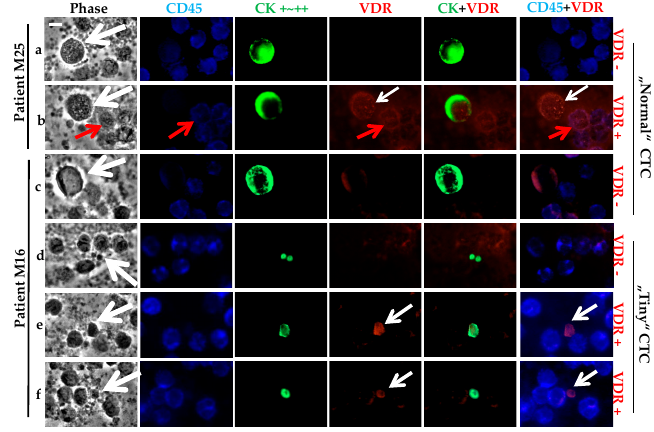
Figure 4. VDR status determination on CTCs of metastatic BC patients. Triple fluorescence labeling of CD45 (in blue), CK (in green), and VDR (in red) was performed on 10 6 PBMCs, with parallel phase analysis. CTCs ( with white arrows ) were classified as VDR+ or VDR-. For both patients M25 ( a , b ) or M16 ( c – f ), either status was observed with superimposed VDR and CK labeling. CTCs exhibit size heterogeneity for patient M16 (“Normal” or “Tiny” CTCs). VDR staining was also seen on PBMCs ( with red arrows ), with superimposed VDR and CD45 labeling. Original magnification, ×40. Scale bar (white bar in the upper left image), 10 μ m.